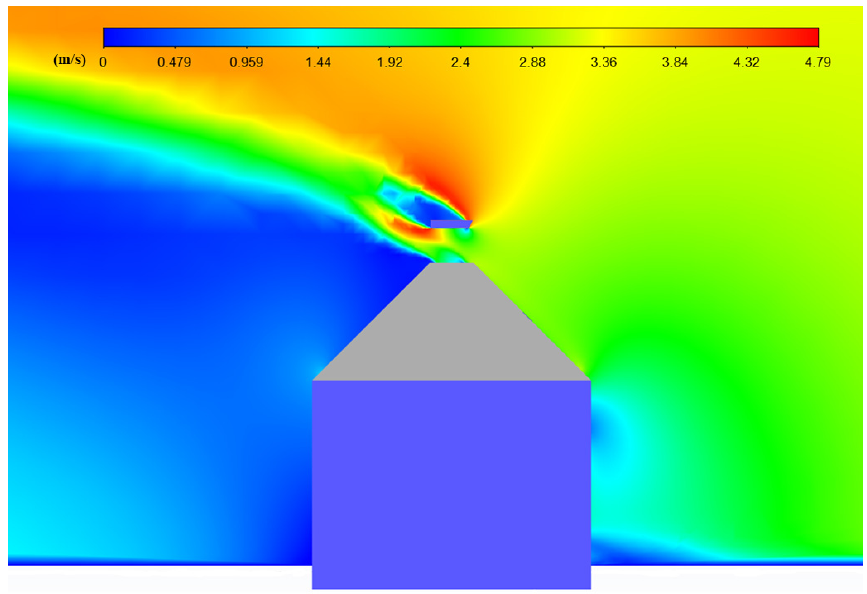
Figure 2. Acceleration due to the venturi effect, simulated by computational fluid dynamics (CFD).